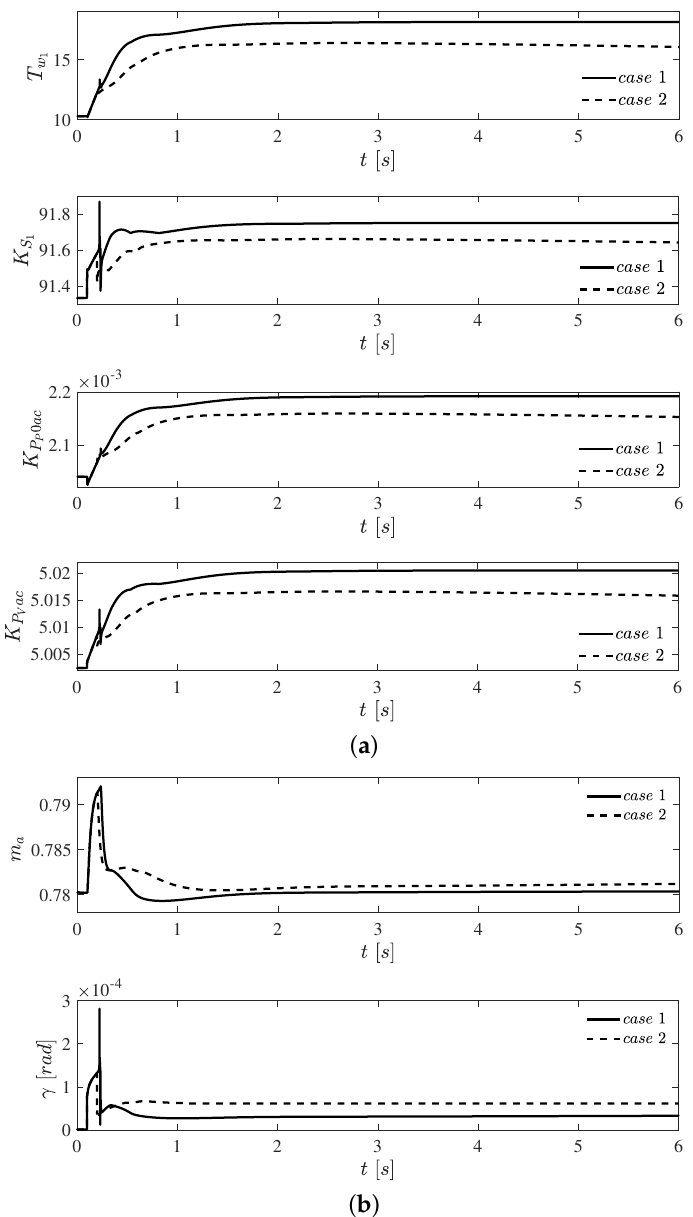
Figure 10. ( a ) Evolution of dynamic gains and; ( b ) Control signals for the